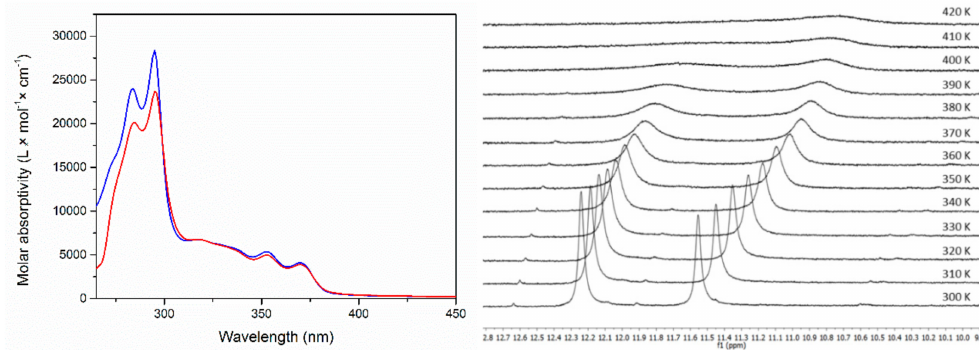
Figure 3. Left: Absorption spectra of 6 in DMSO as a function of the concentration while keeping the product between the concentration value and the path length constant (5.0 × 10 − 5 M). The concentrations are as follows: blue solid line: 5.0 × 10 − 4 M (most concentrated); red solid line: 5.0 × 10 − 6 M (most diluted). Right: High shift region from variable temperature 1 H-NMR spectra of Compound 6 , in